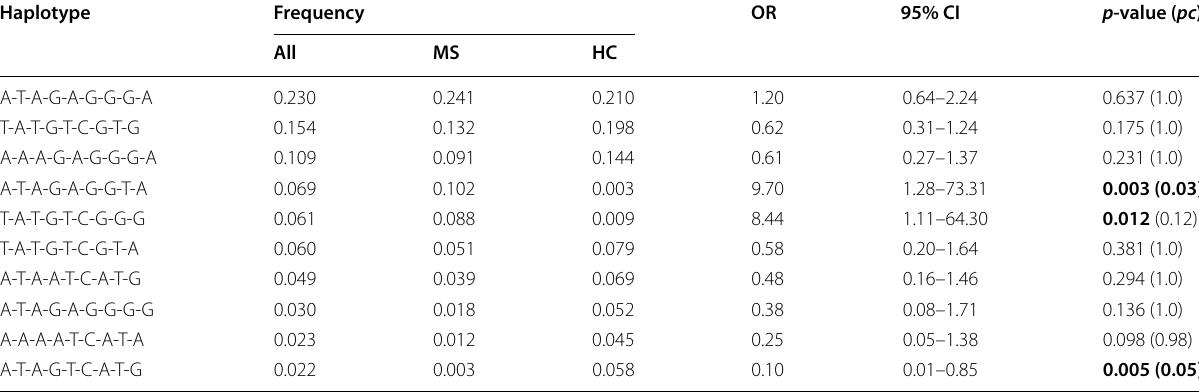
Table 3 Estimated frequencies of nine-locus haplotypes of TLR10 gene SNPs (in the order: rs200395112, rs201802754,